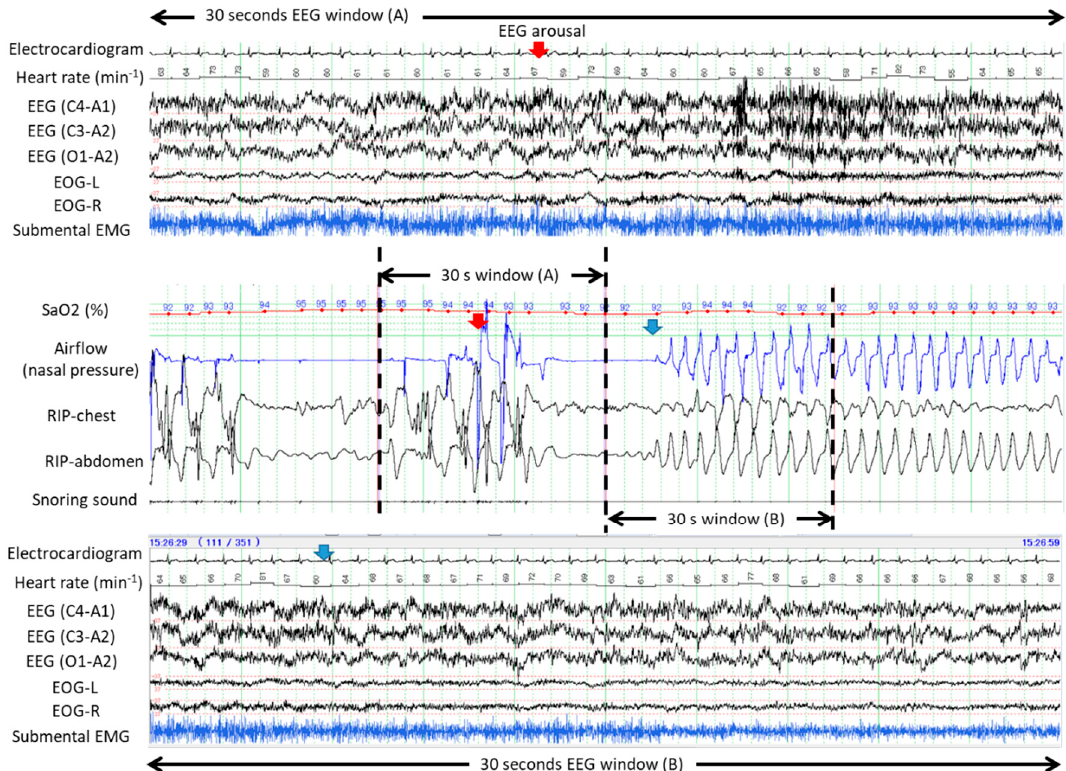
Figure 1. Five-minute polysomnographic tracings demonstrating restorations from obstructive apneas with and without cortical arousal during endoscopic submucosal dissection (ESD) procedure under propofol sedation. The upper panel of 30 seconds window ( A ) evidenced presence of cortical arousal in accordance with abrupt recovery from the first apnea while no cortical arousal occurred during gradual recovery from the second apnea as evidenced by the bottom panel of 30 seconds window ( B ).